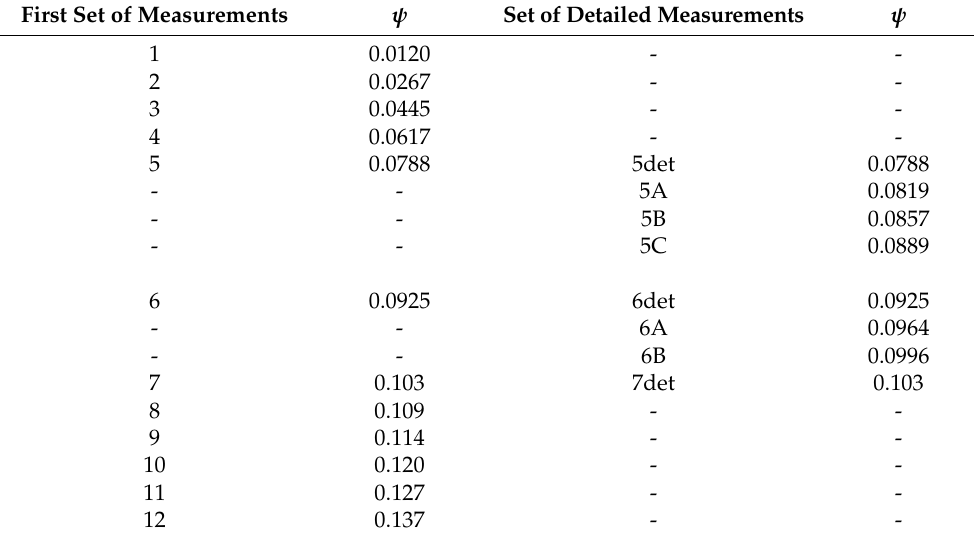
Table 1. Investigated operating conditions.